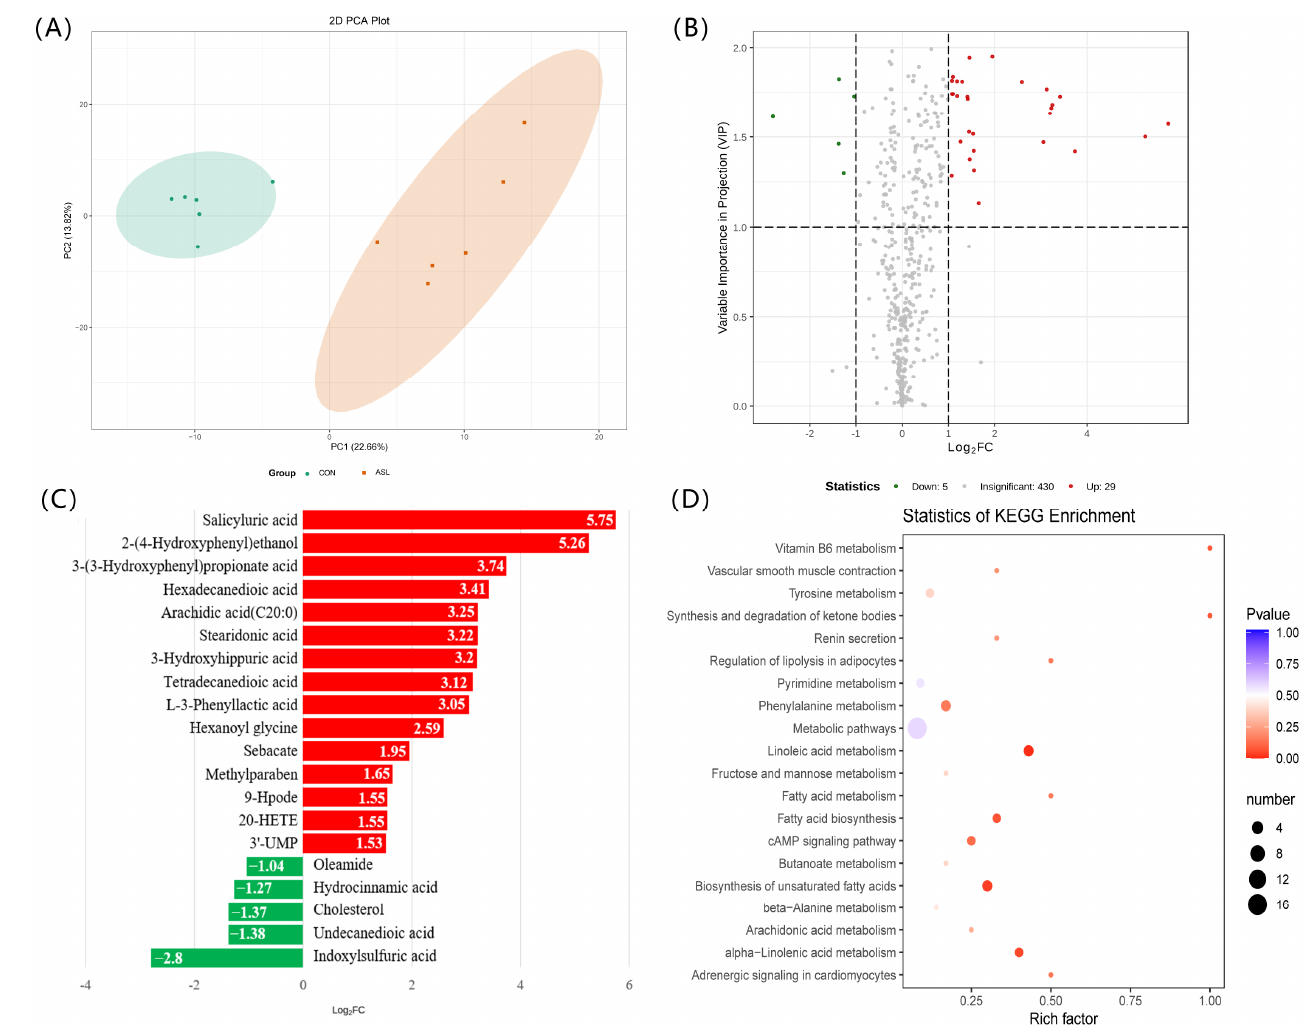
Figure 3. Serum metabolomics analysis reveals changes in the metabolites and their associated signal pathways in response to feeding A. sinensis leaves to goats. ( A ) The PCA score plot of serum metabolome distribution shows clear separate clusters for goats with different diets. ( B ) A volcano plot showing differential serum metabolites between the CON and ASL groups. ( C ) Top 20 differential serum metabolites between the CON and ASL groups. ( D ) The KEGG enrichment analysis suggests significant changes occurred in the signal pathways of unsaturated fatty acid biosynthesis, linoleic acid metabolism, and α -linolenic acid metabolism. CON: a normal diet; ASL: a diet containing 20% A. sinensis leaves. Red indicates an increase, while green indicates a decrease. 20-HETE: 20-hydroxy- 5Z,8Z,11Z,14Z-eicosatetraenoic Table 4. Serum metabolites that differ significantly in the goat samples after feeding A. sinensis leaves using UPLC-MS/MS analysis.